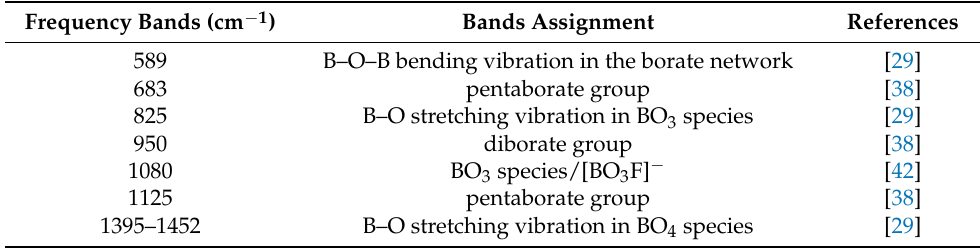
Table 2. FTIR main band assignments for different xNaF · (100-x)BaO · 2B 2 O 3 glass